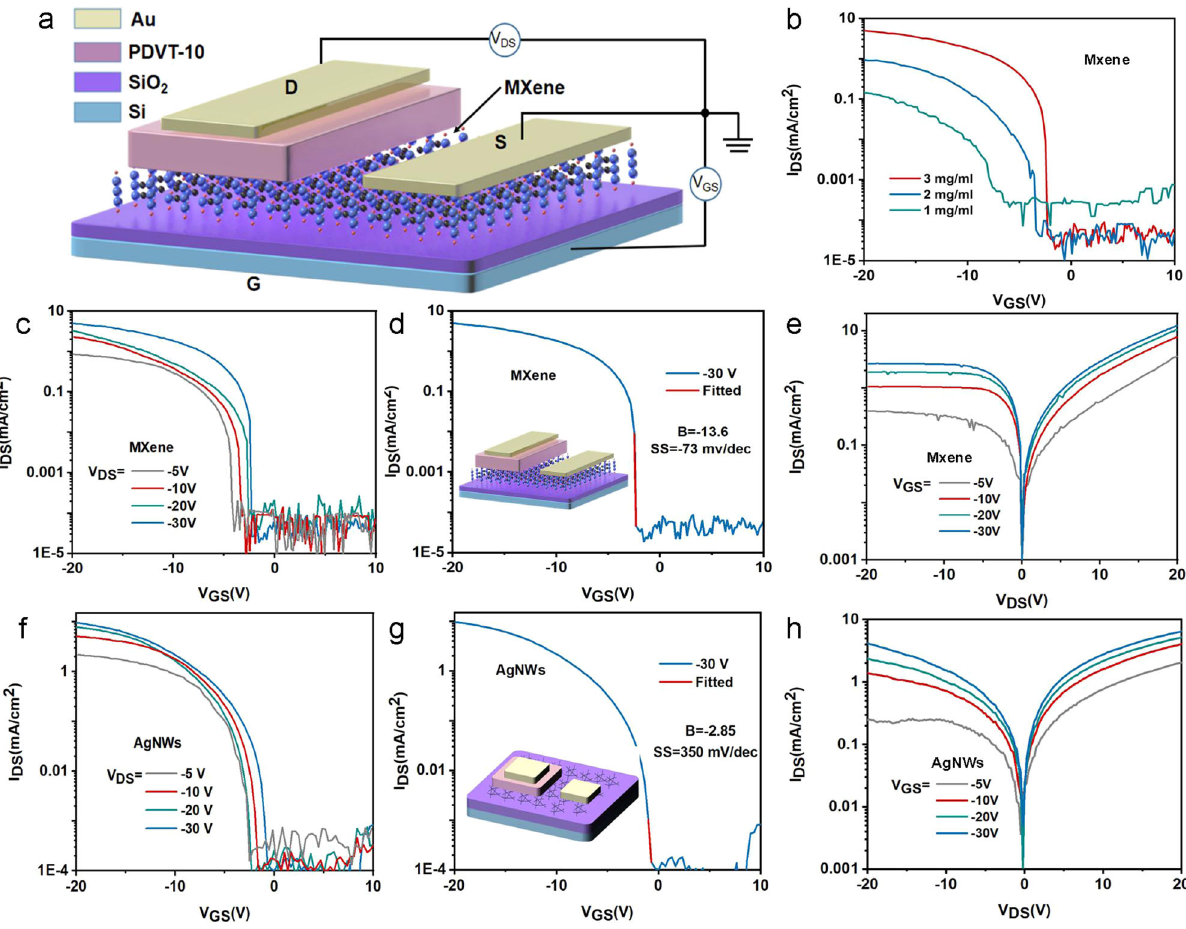
Fig. 2 The essential transistor performance of MVOFET. a The schematic diagram of device structure of MVOFET. b The transfer curves of MVOFET under different concentration of MXene. c The transfer curves of MVOFET under different V DS at a concentration of 3 mg/ml MXene. d The transfer curve at V DS = − 30 V, indicating a high on/off ratio over 10 5 , small threshold voltage of − 1.2 V and small SS of 73 mv/dec. e Output characteristic of MVOFET exhibiting a signi fi cant saturation current under small V DS . f The transfer curves of VOFET utilizing AgNWs as source electrode. g The transfer curve at V = − 30 V of VOFET made by AgNWs. h Output characteristic of AgNWs-based VOFET under different V DS